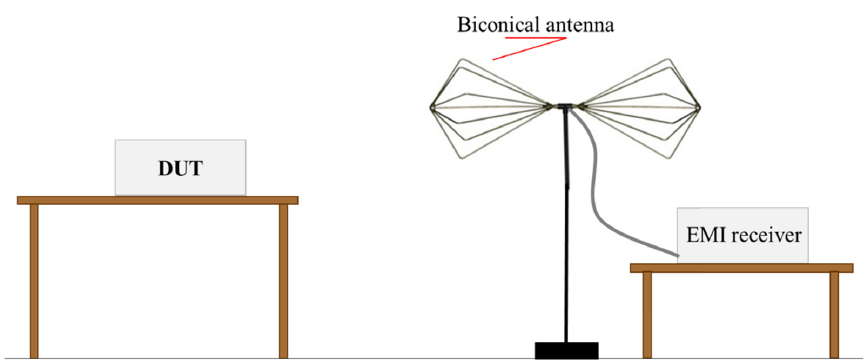
Figure 6. Radiated emission test set-up.